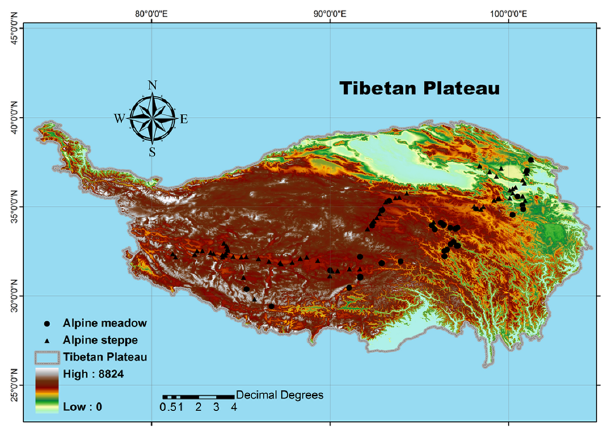
Fig. 1. Spatial distribution of the sampling sites in the alpine grass- lands on the Tibetan Plateau, China. Samples were collected in the alpine meadow (circles) and alpine steppe (triangles) from 2001 to